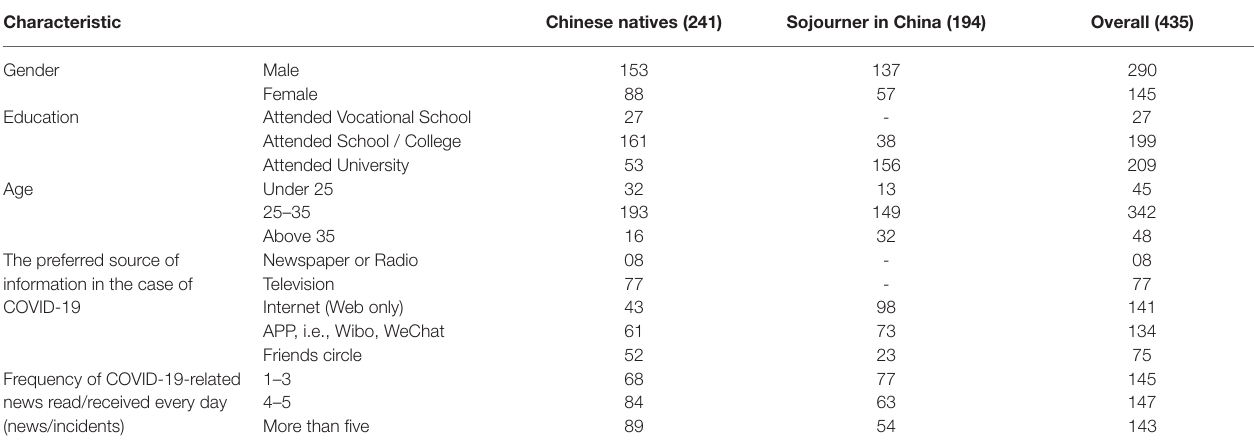
TABLE 1 | Demographic profile of respondents.